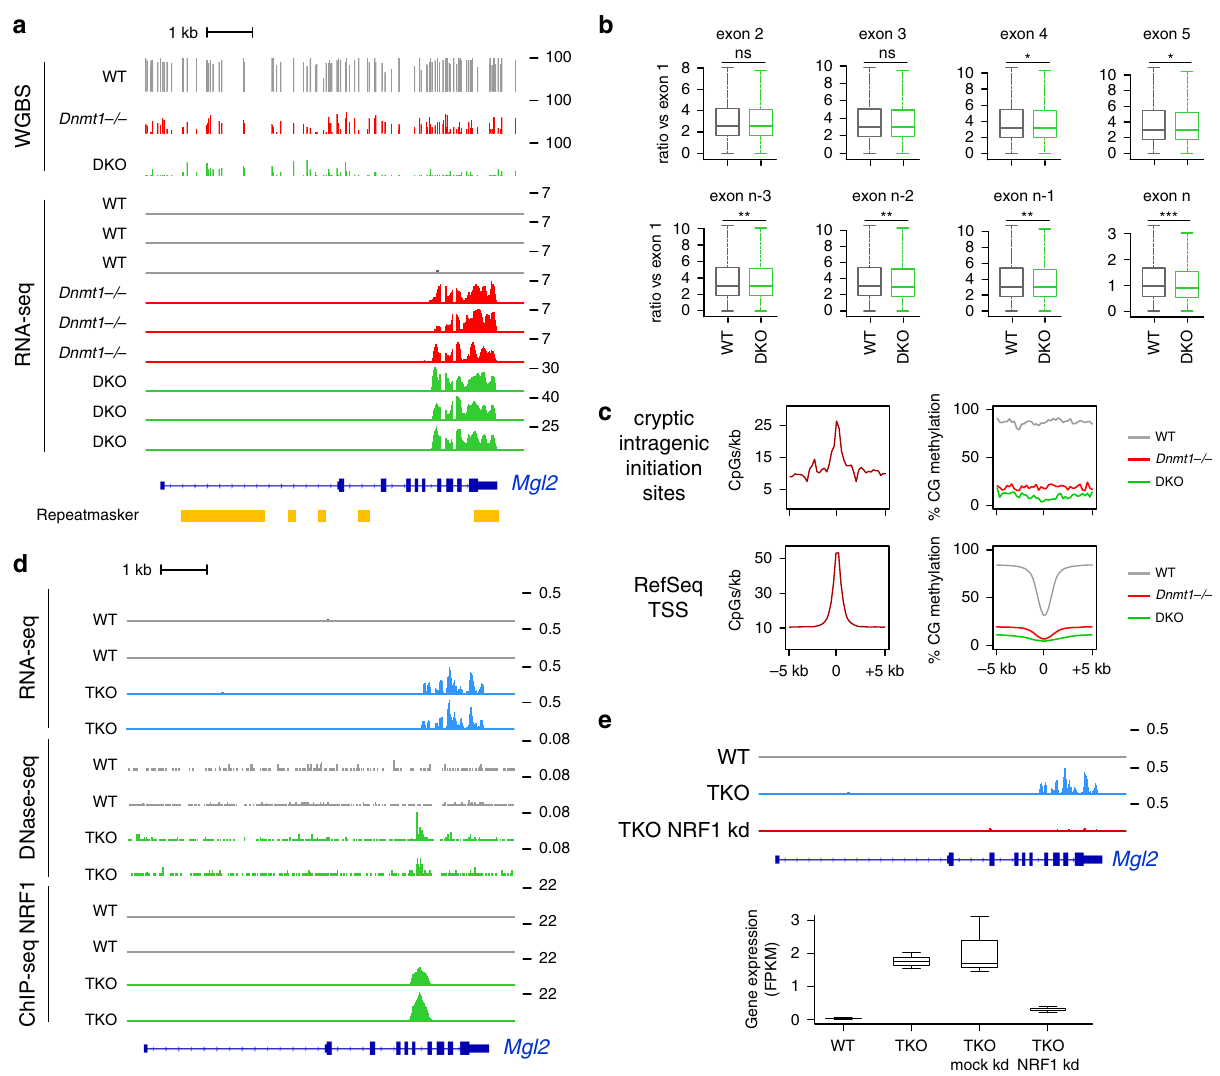
Fig. 6 Transcripts initiate from cryptic intragenic promoters in Dnmt mutant embryos. a Genome browser tracks of WGBS and RNA-seq pro fi les at the Mgl2 locus in WT and Dnmt mutant embryos. One WGBS replicates and three RNA-seq replicates are shown. RepeatMasker annotations are displayed in yellow below the tracks. b Boxplot of the ratio of RNA-seq read counts in downstream exons compared to the fi rst exon in WT and DKO embryos for all expressed genes with at least 5 exons ( n = 12,898). Exon n represents the last exon of the gene. ns: not signi fi cant; * p < 0.05; ** p < 0.01; *** p < 0.001 (Wilcoxon test). c Metaplots representing the CpG density and the CpG methylation levels in 5 kb sequences fl anking cryptic intragenic initiation sites or canonical RefSeq TSS. d Genome browser tracks of RNA-seq, DNAse-seq and NRF1 ChIP-seq pro fi les at the Mgl2 locus in WT and Dnmt triple knockout (TKO) ES cells. Two replicates are shown. e The genome browser tracks on the top display Mgl2 RNA-seq pro fi les upon NRF1 knockdown in TKO ES cells. The boxplot on the bottom shows the quanti fi cation of Mgl2 expression measured by RNA-seq (plotted as FPKM) upon mock and NRF1 knockdown in TKO ES cells ( n = 3 replicates). In the boxplots the line indicates the median, the box limits indicate the upper and lower quartiles and the whiskers extend to 1.5 IQR from the